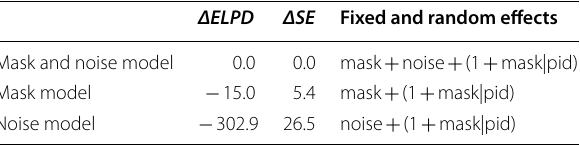
Table 5 Change in LOO information criterion relative to the best fitting model without an interaction term for the subjective listening effort analysis in older